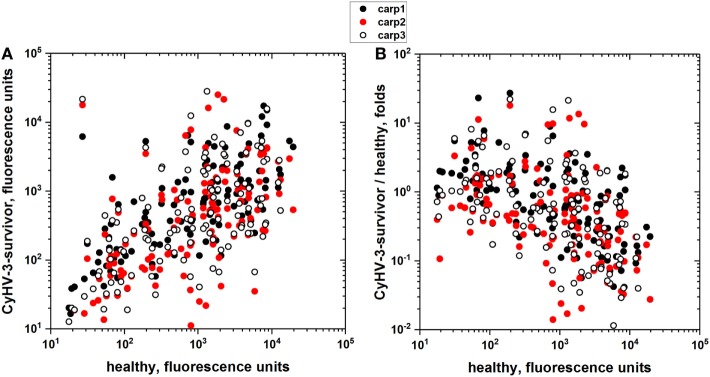
IgM-binding antibodies to an array of recombinant human proteins in the sera from cyprinid herpes virus 3 (CyHV-3) infection-survivor and healthy carp. Individual carp sera from CyHV-3 infection-survivor with high anti-CyHV-3 titers and healthy carp with no anti-CyHV-3 titers were screened for IgM binding to an array of 128 human proteins. Sera from CyHV-3 infection-survivor (n = 3) and healthy (n = 2) carp were 100-fold diluted and incubated with the protein arrays. IgM binding was detected with the corresponding Cy3-labeled anti-carp IgM MAb8. Backgrounds resulting from arrays incubated in the absence of sera were subtracted. (A) IgM binding of sera from CyHV-3 infection survivor versus healthy carp sera. (B) Folds versus healthy carp sera, folds calculated for each protein by the formula, fluorescence of CyHV-3 infection-survivor carp sera/mean of fluorescences of the healthy carp sera. Each circle represents one of the proteins in the array. Black circles—IgM binding of CyHV-3 infection-survivor carp 1. Red circles—IgM binding of CyHV-3 infection-survivor carp 2. Open circles—IgM binding of CyHV-3 infection-survivor carp 3.